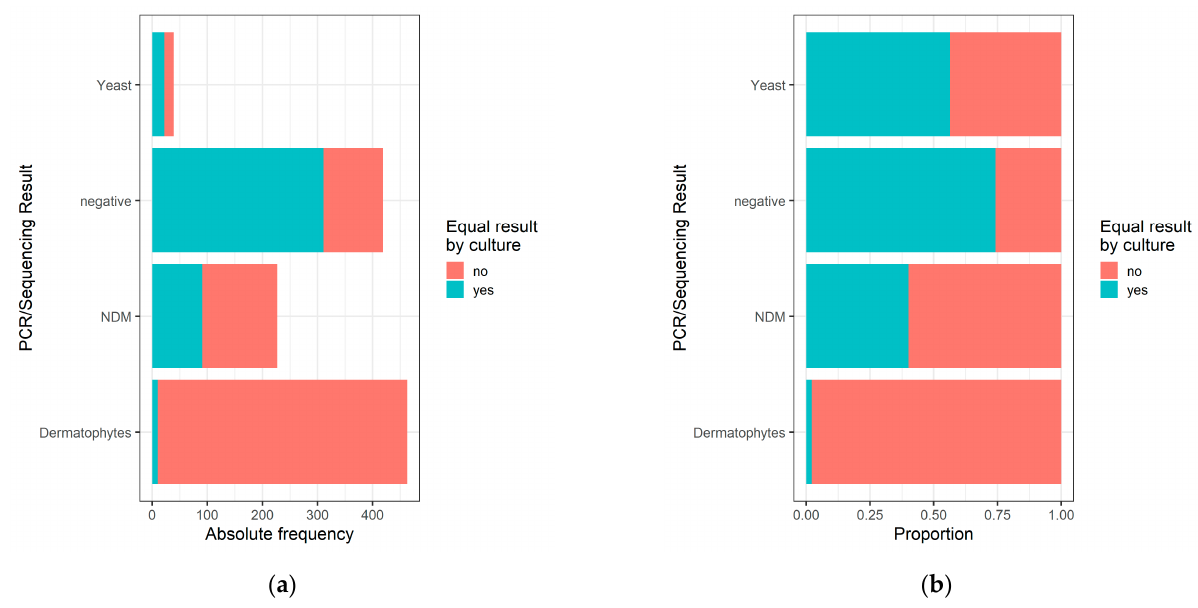
Figure 1. Comparison of PCR/sequencing with the respective culture results in absolute ( a ) and relative ( b ) numbers. Only a small number of dermatophyte infections identified by PCR/sequencing was also detected by culture, whereas the proportion was higher for yeast and NDM infections.